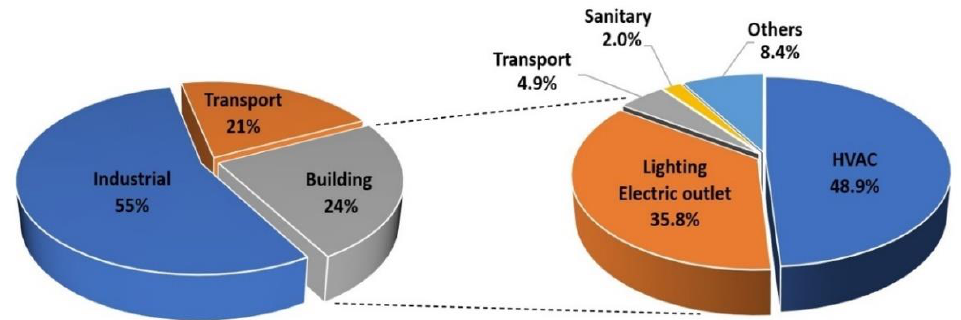
Figure 1. The type of energy consumption in buildings.